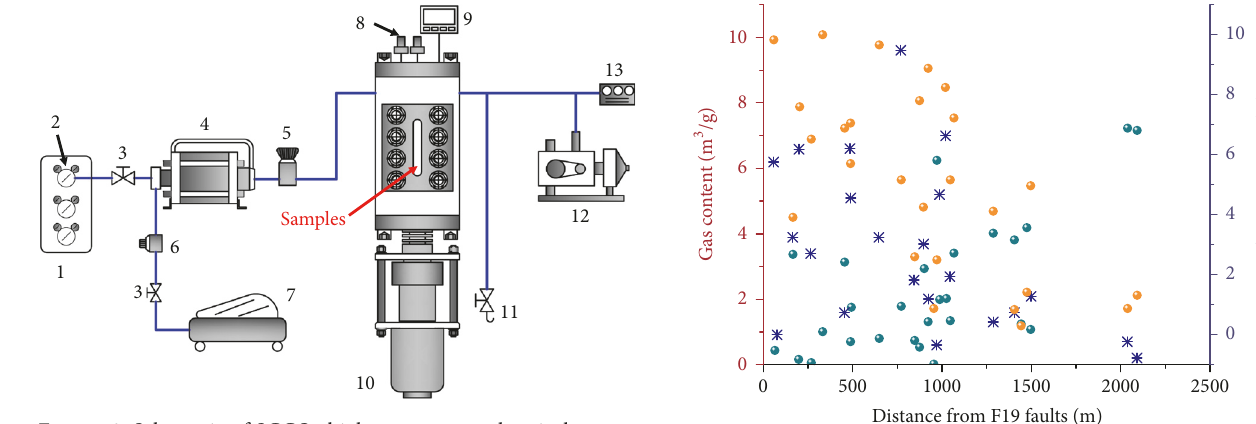
Figure 3: Schematic of SCCO 2 high-pressure geochemical reactor simulating CO 2 injection. (1) Gas supply; (2) reducing valve; (3) valve; (4) gas booster pump; (5) reducing valve; (6) pressure regulating valve; (7) air compressor; (8) temperature and pressure transducers; (9) temperature and pressure indicator; (10) SCCO 2 high-pressure geochemical reactor; (11) safety valve; (12) vacuum pump; (13) vacuum gauge.